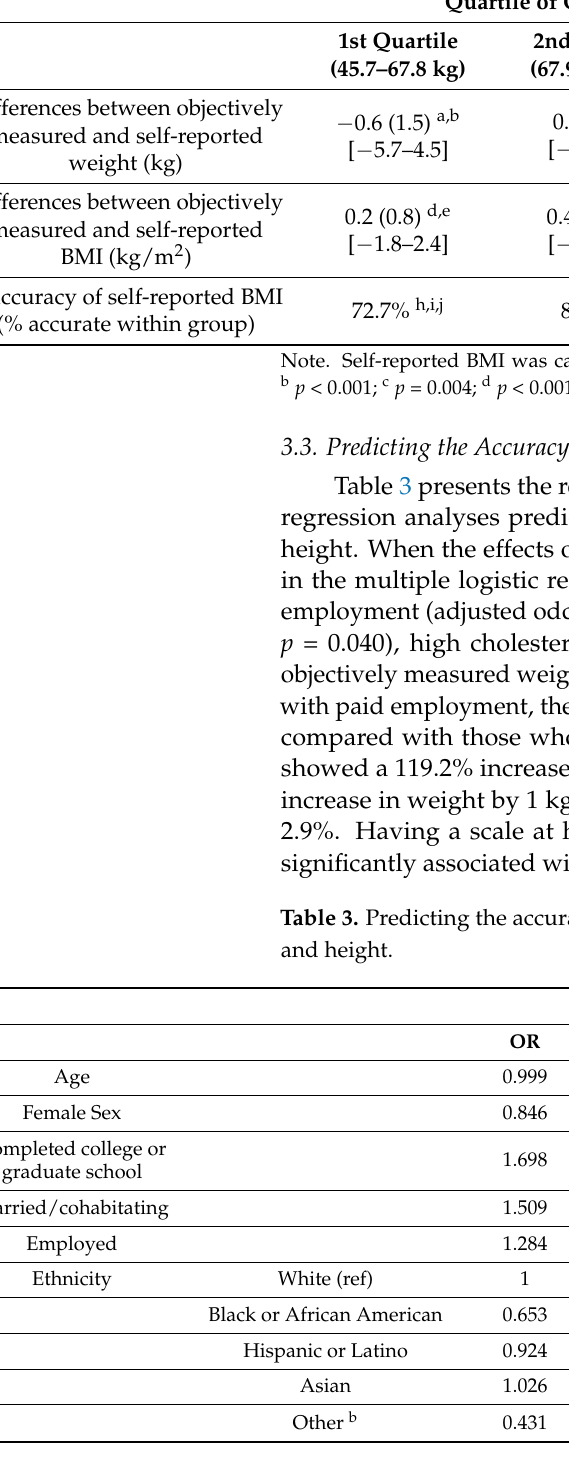
Table 2. Mean, standard deviation, and range of differences in objectively measured and self-reported weight and body mass index (BMI) by objectively measured weight groups ( n = 531).